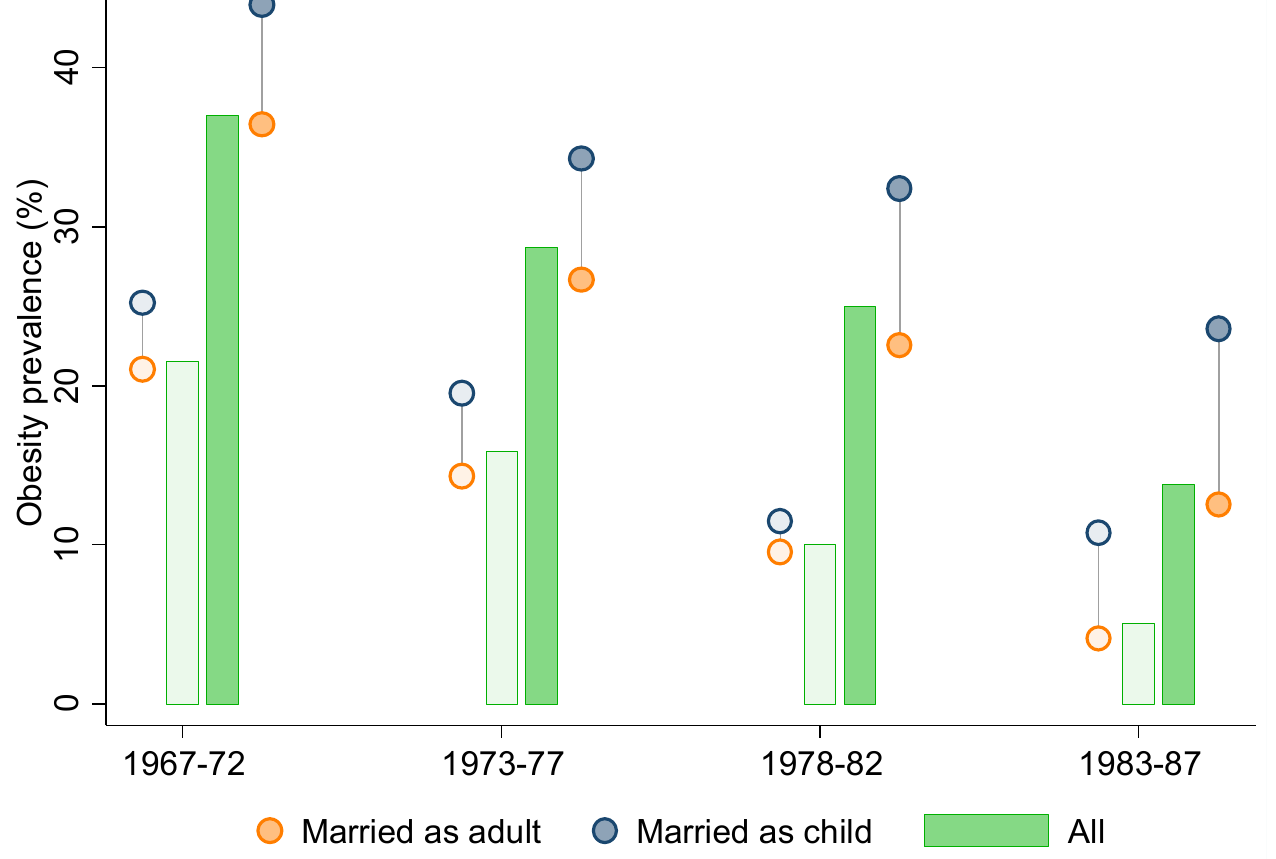
Figure 3. Obesity prevalence by survey wave, birth cohort, and child marriage. The lighter and darker shades of the same color represent 2012 and 2017 survey waves, respectively. The differences in obesity prevalence between women married as children and married as adults were statistically significant for the youngest birth cohort (i.e., 1983–1987) in both survey waves, and for the 1978–1982 birth cohort in the 2017 survey wave. The differences were not statistically significant for the older birth cohorts (i.e., 1973–1977 and 1967–1972) in either survey